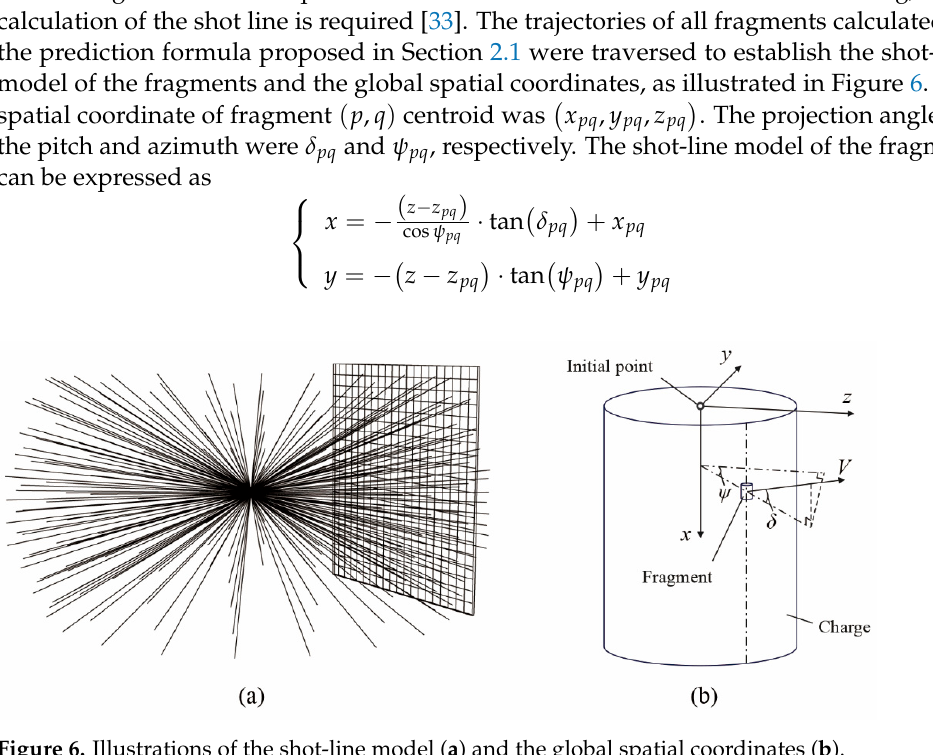
Figure 6. Illustrations of the shot-line model ( a ) and the global spatial coordinates ( b ).